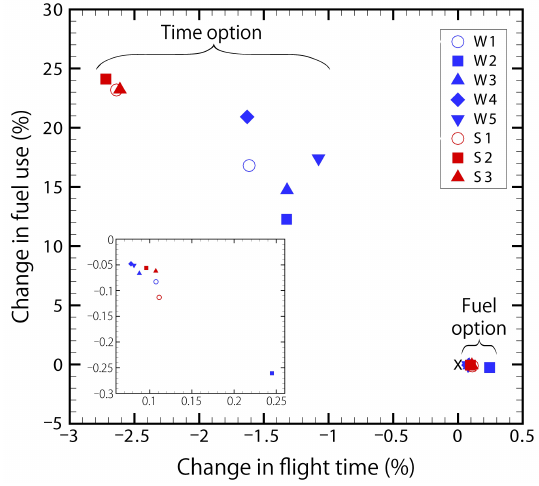
5 Figure 5. Relative changes in the flight time and fuel use for the one-day air traffic simulations with the time and the fuel routing options, including the enlarged drawing of the fuel optimal results. A symbol indicates the combined effect of 103 flights; for all the weather types, the results of the COC routing option are taken as the reference indicated by the cross “x” at the point of